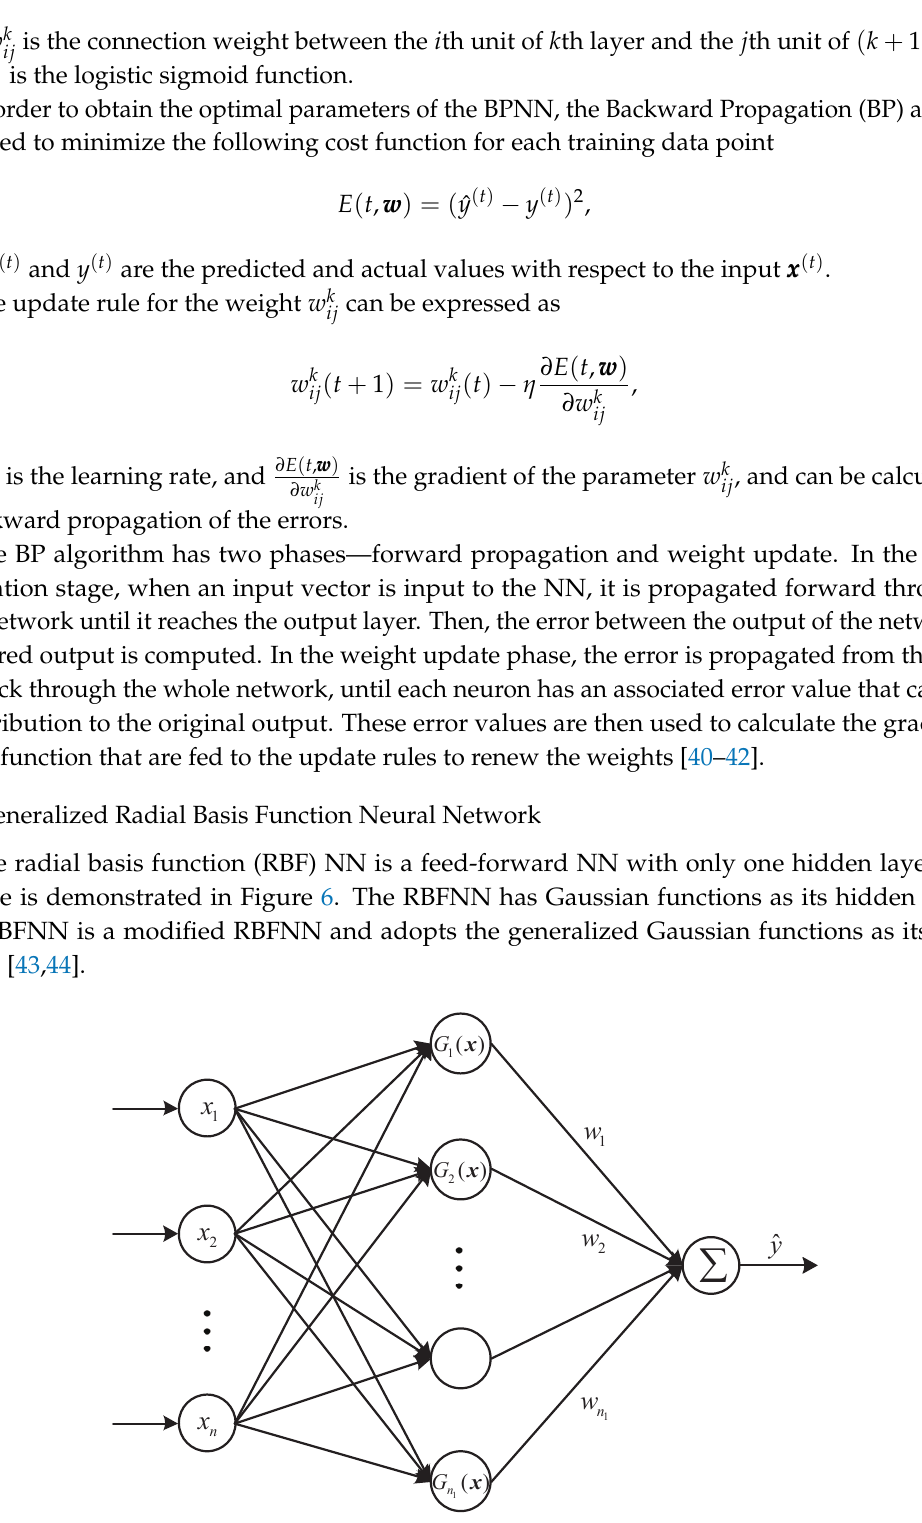
Figure 6. The topological structure of the feed-forward single-hidden-layer